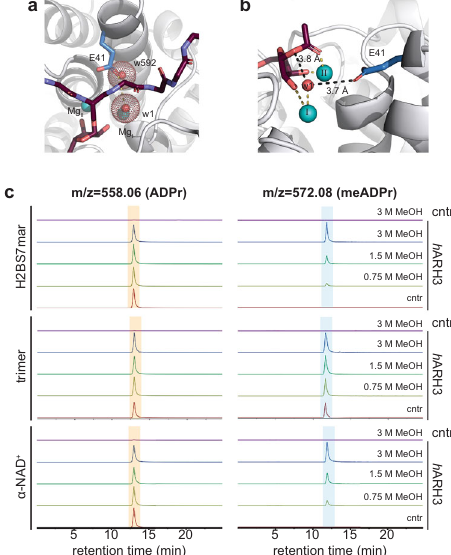
Fig. 7 Analysis of reaction initiation and progression in the ARH3 catalytic cycle. a Model of h ARH3 wt in complex with H2BS7mar. Glu41 (blue) adopts a conformation within the second coordination sphere of both Mg 2 + ions. Water molecules shown (red sphere) belong to the model (w1, axial water) or to the template h ARH3:H2BS7mar structure (w592, chain A), respectively. Side-chain atoms of the peptide (purple) were omitted for clarity. b Model of h ARH3 wt in complex with O AADPr. The axial water of Mg I (w1; red sphere) was included into the model. Selected magnesium coordination bonds are shown in yellow and distances between model Glu41, w1 and scissile bond oxygen are shown in black. c High- resolution mass spectrometry analysis of solvolysis of H2BS7mar, trimeric PAR and α -NAD + in the presence and absence of methanol. Shown are the total negative ion counts for ADPr [M − H] − with a m / z of 558.06 (left panels) meADPr [M − H] − with a m / z of 558.06 (right panels). Ion chromatograms were extracted setting tolerance at 10 ppm. Note, that trimeric PAR contains meADPr, which is released upon cleavage and increases experimental background. Source data are provided as a Source data fi